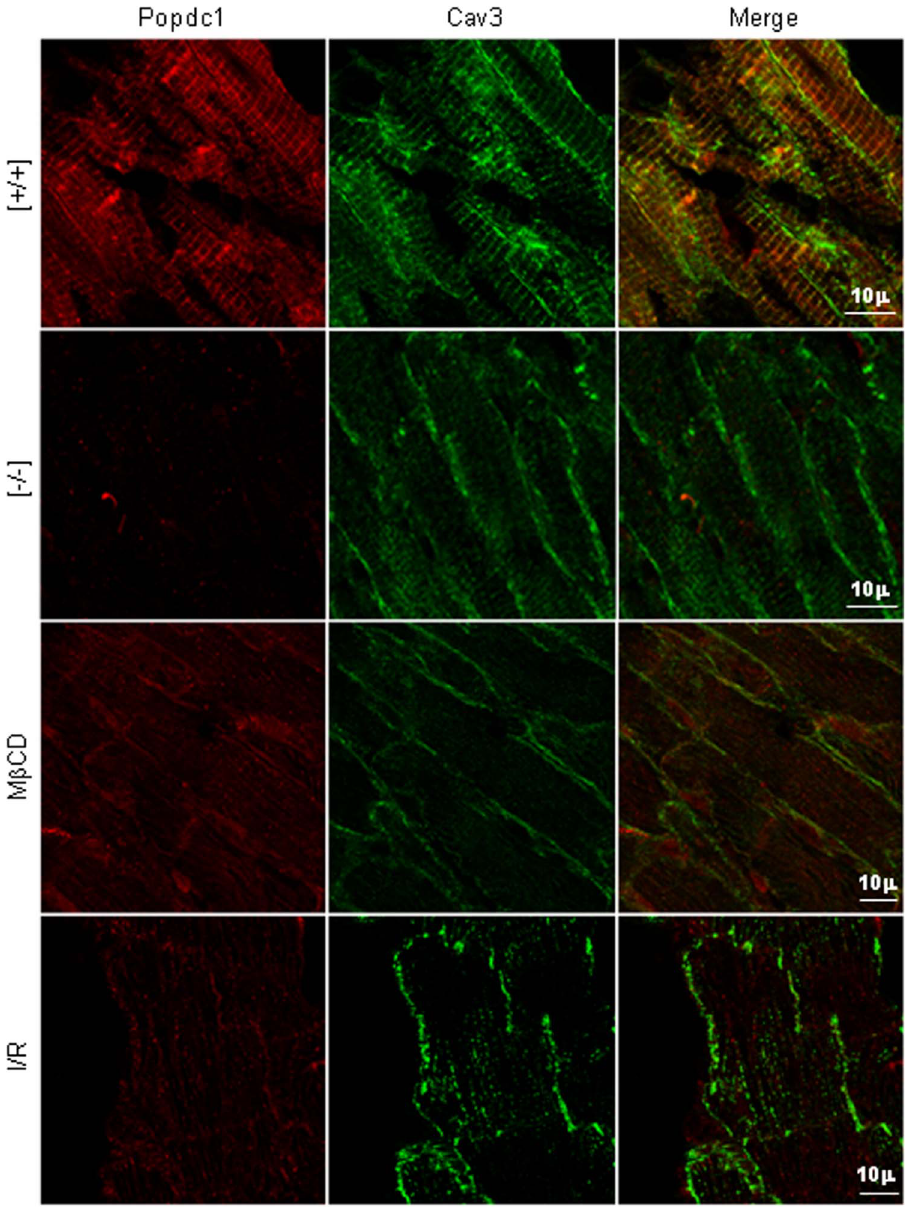
Figure 4. Popdc1 and Cav3 distribution in normal, mutant and injured hearts. Confocal microscopy images depicting Popdc1 (red) and Cav3 (green); co-localization sites appear in yellow. Note the low staining intensity of Cav3 cross striations in the Popdc1 -null and M b CD-treated hearts, and the disappearance of Popdc1 and Cav3 co-localization following I/R.